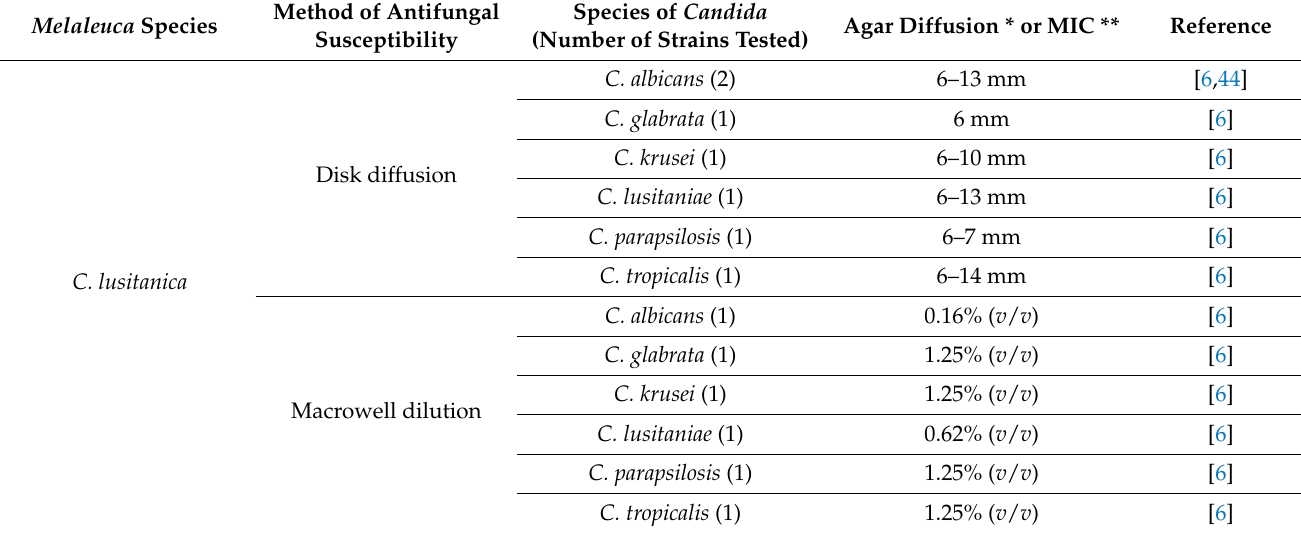
Table 3. In vitro antifungal activities of Cupressus spp. and Litsea spp. essential oils tested against Candida species according to different